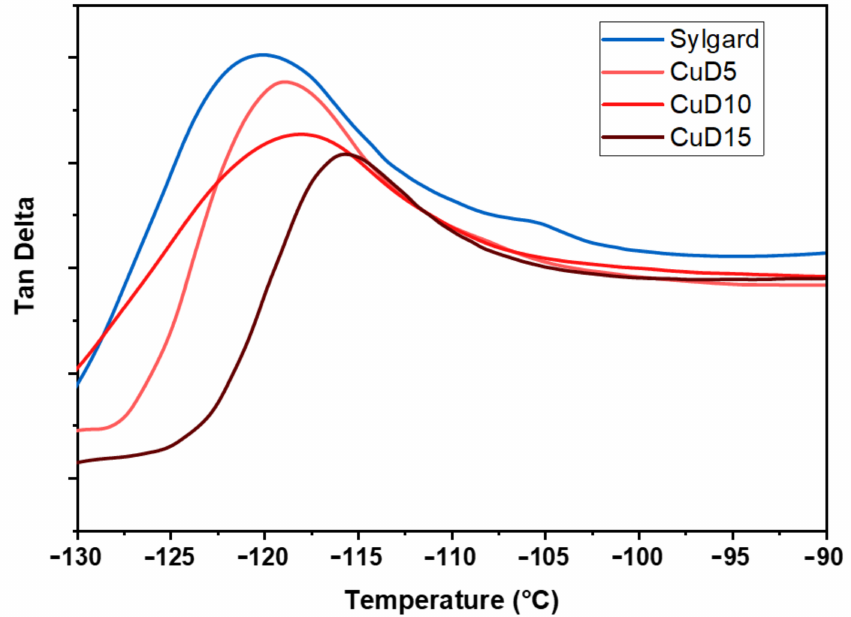
Figure 5. Tan δ curve of DMTA analysis for the composite containing dendritic copper particles.